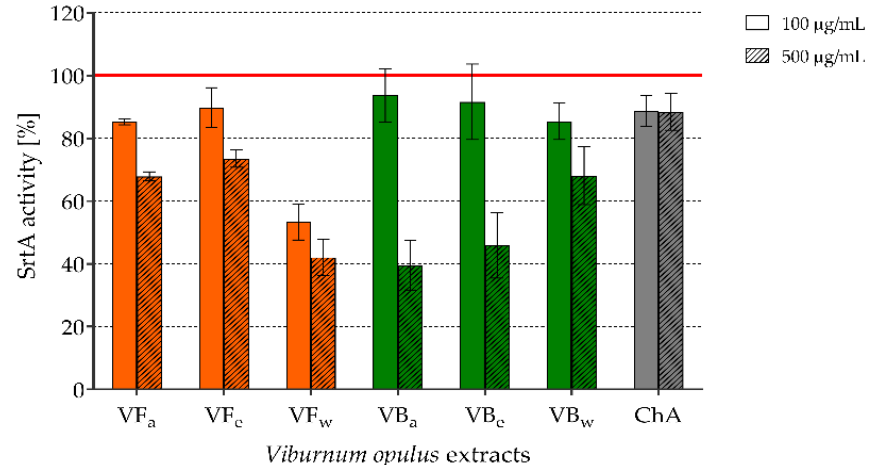
Figure 2. The effect of V. opulus extracts on staphylococcal sortase A (SrtA) activity after 30 min incubation with the substrate; VF— V. opulus fruit extract; VB— V. opulus bark extract; a/e/w—acetonic/ethanolic/water extract; ChA—chlorogenic acid.